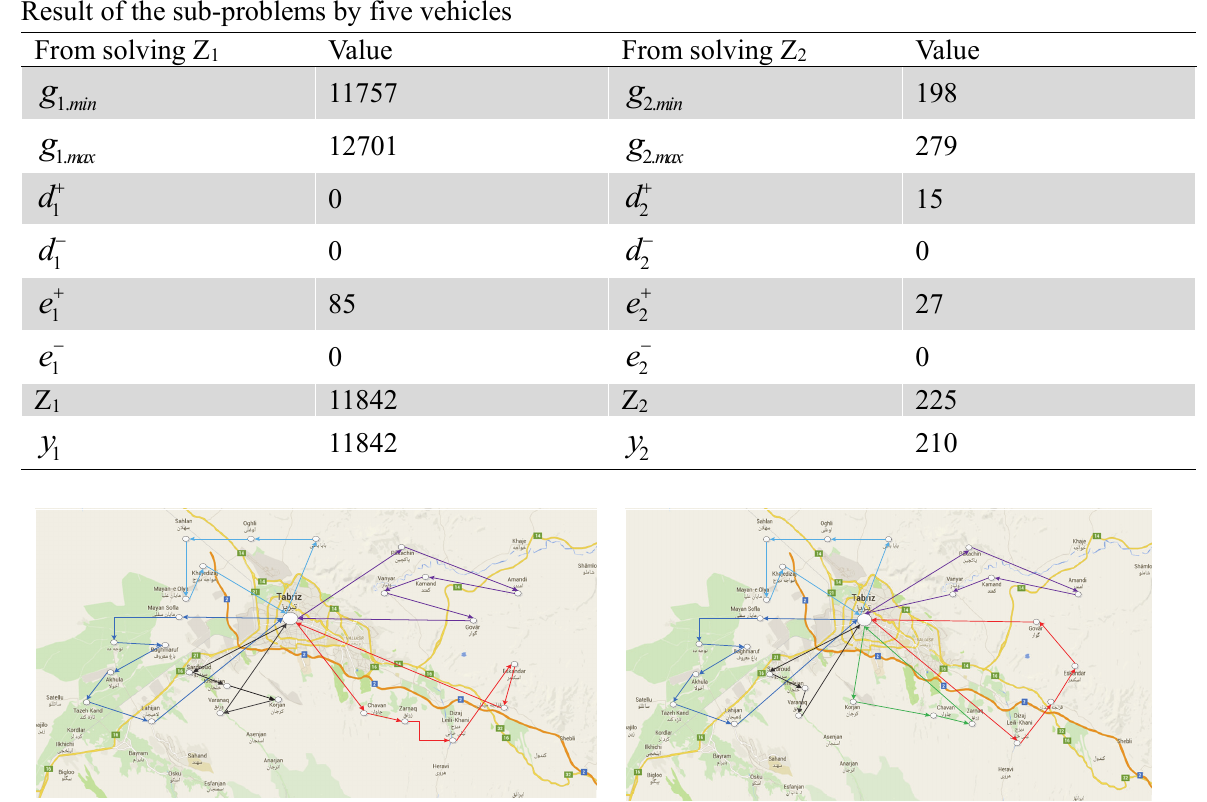
Fig. 8 . Solution of the case study by five vehicles Fig. 9. Solution of the case study by six